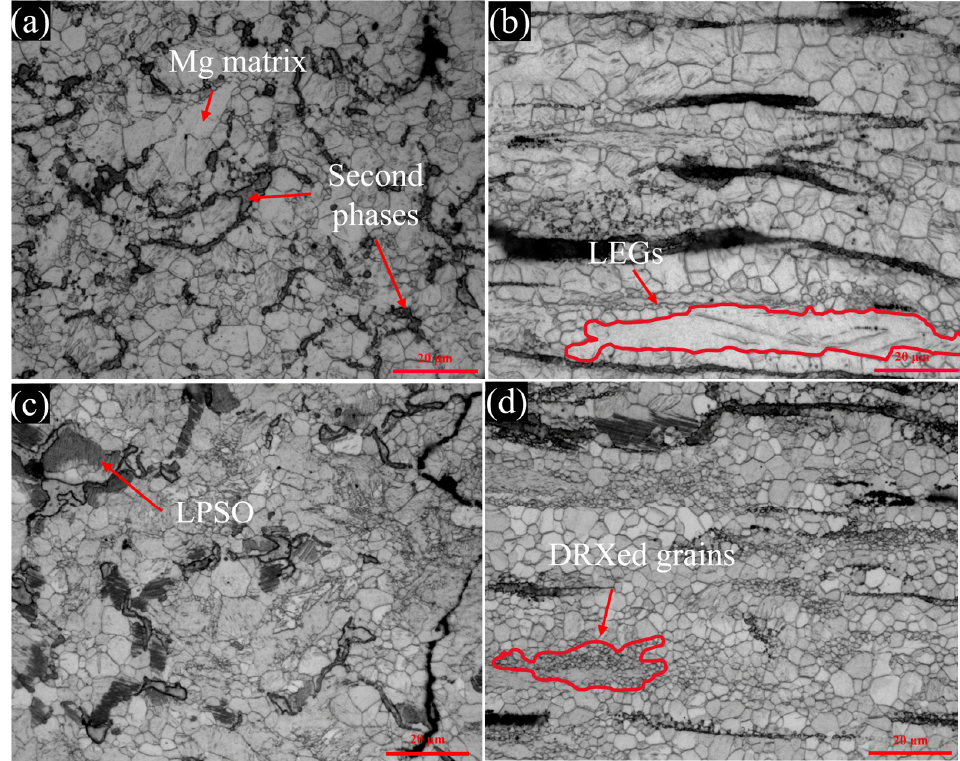
Figure 1. Optical micrographs of the alloy perpendicular ( a , c ) and parallel ( b , d ) to the extrusion direction for the ( a , b ) as-extruded alloy and ( c , d ) as-aged alloy.